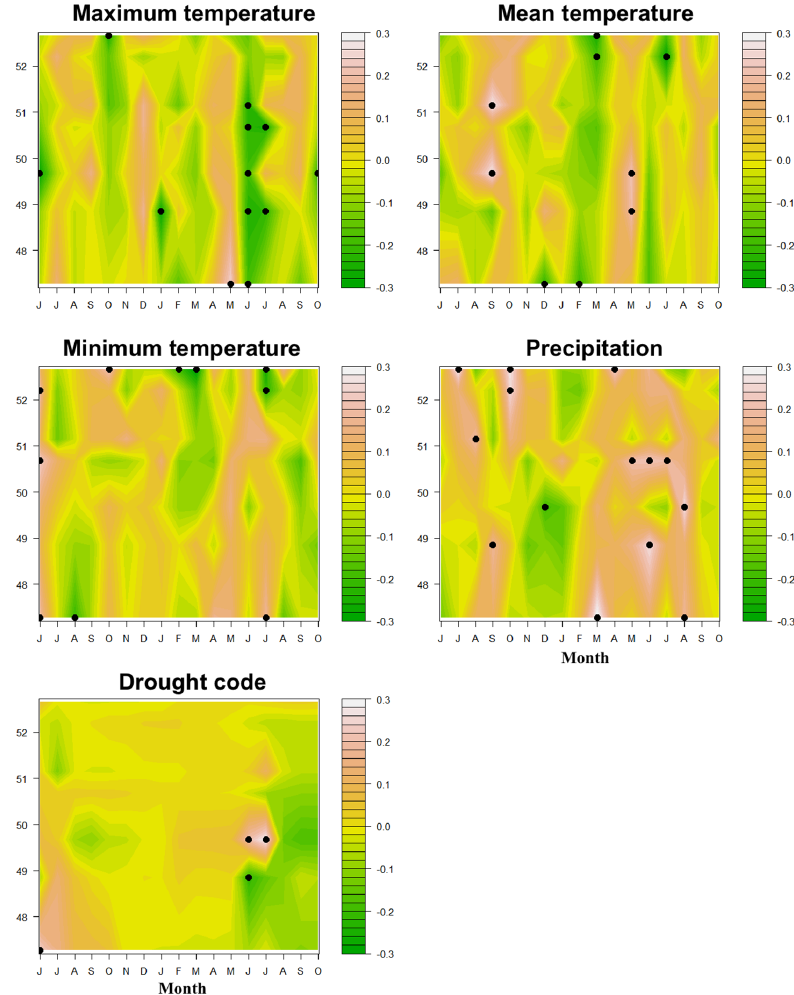
Figure 4. Bootstrapped correlation coefficients between Larix gmelinii residual tree-ring chronologies and the monthly climate variables (monthly maximum, mean, and minimum temperatures, monthly total precipitation, and monthly drought code) for the period 1960–2013 along the latitudinal gradient from 47.27° to 52.66° N in the boreal forest of the western Greater Khingan Mountains in Northeastern China. The black dots indicate significant correlations at the p < 0.05 level.